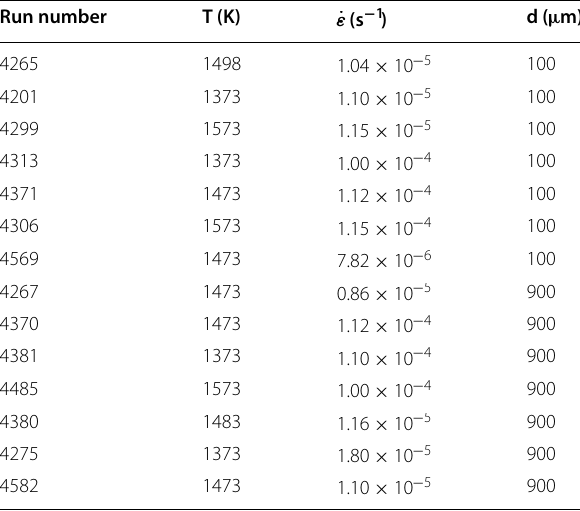
Table 2 Experimental conditions for the deformation of wet dunites from Chopra and Paterson (1981). All the experiments were reported in Chopra and Paterson (1981). However, some stress-versus-strain series were published as part of Chopra and Paterson (1984) and Chopra (1986)